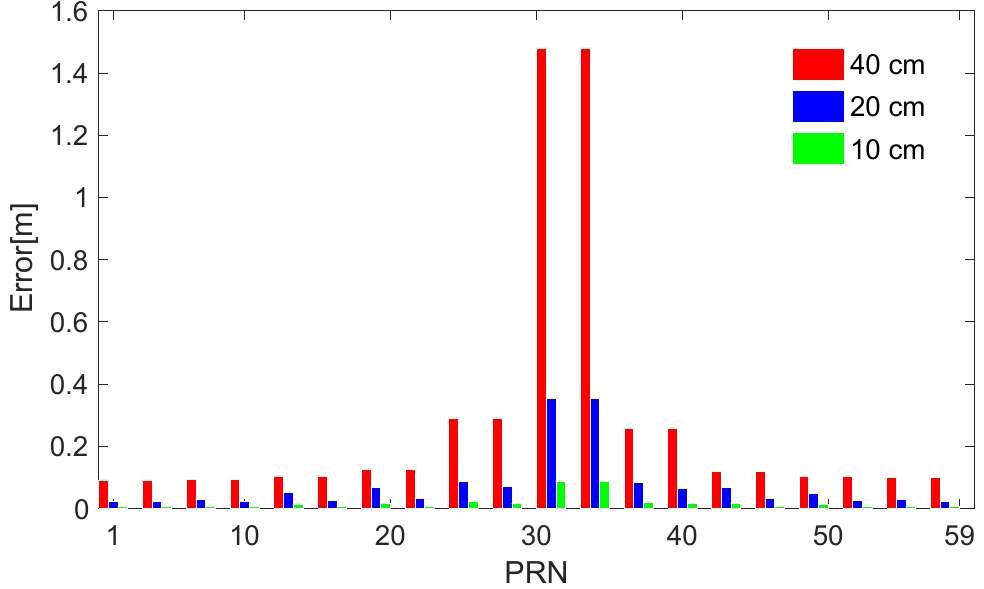
Figure 6. 60-LEO constellation 3D orbital errors under different ranging accuracies. Table 3. Average orbital errors of 60-LEO constellation under different ranging accuracies.